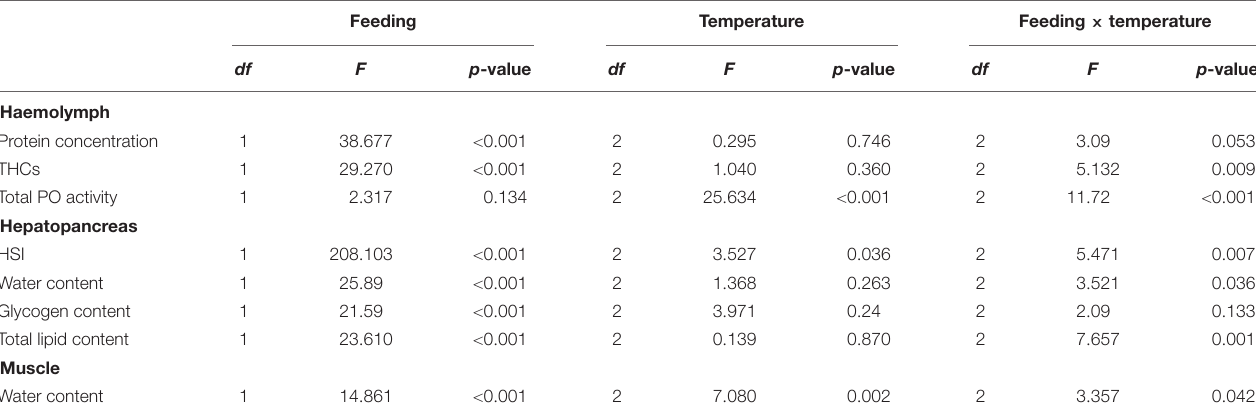
TABLE 4 | Two-factor ANOVA on the parameters measured in the hemolymph, hepatopancreas and muscle of H. gammarus fed and unfed at different holding temperatures (4, 8, 12 ◦ C) after being held in captivity for 24 weeks included in the PCA. Feeding Temperature Feeding ×